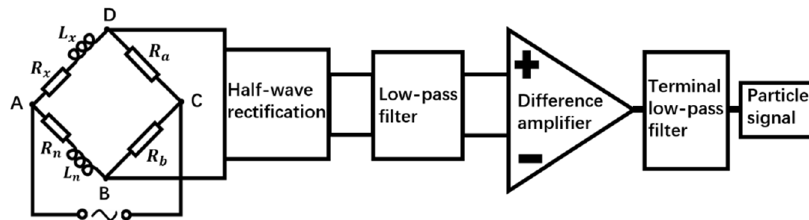
Figure 5. Schematic diagram of detection circuit